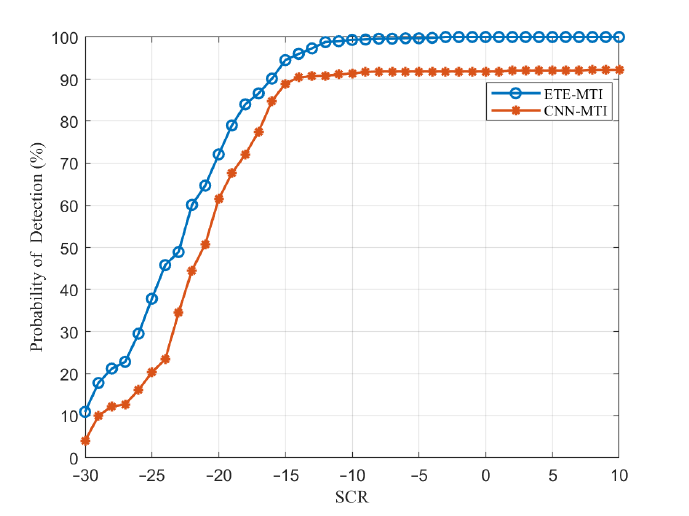
Figure 9. PD versus SCR curves of the proposed ETE-MTI and the CNN-MTI method [31]